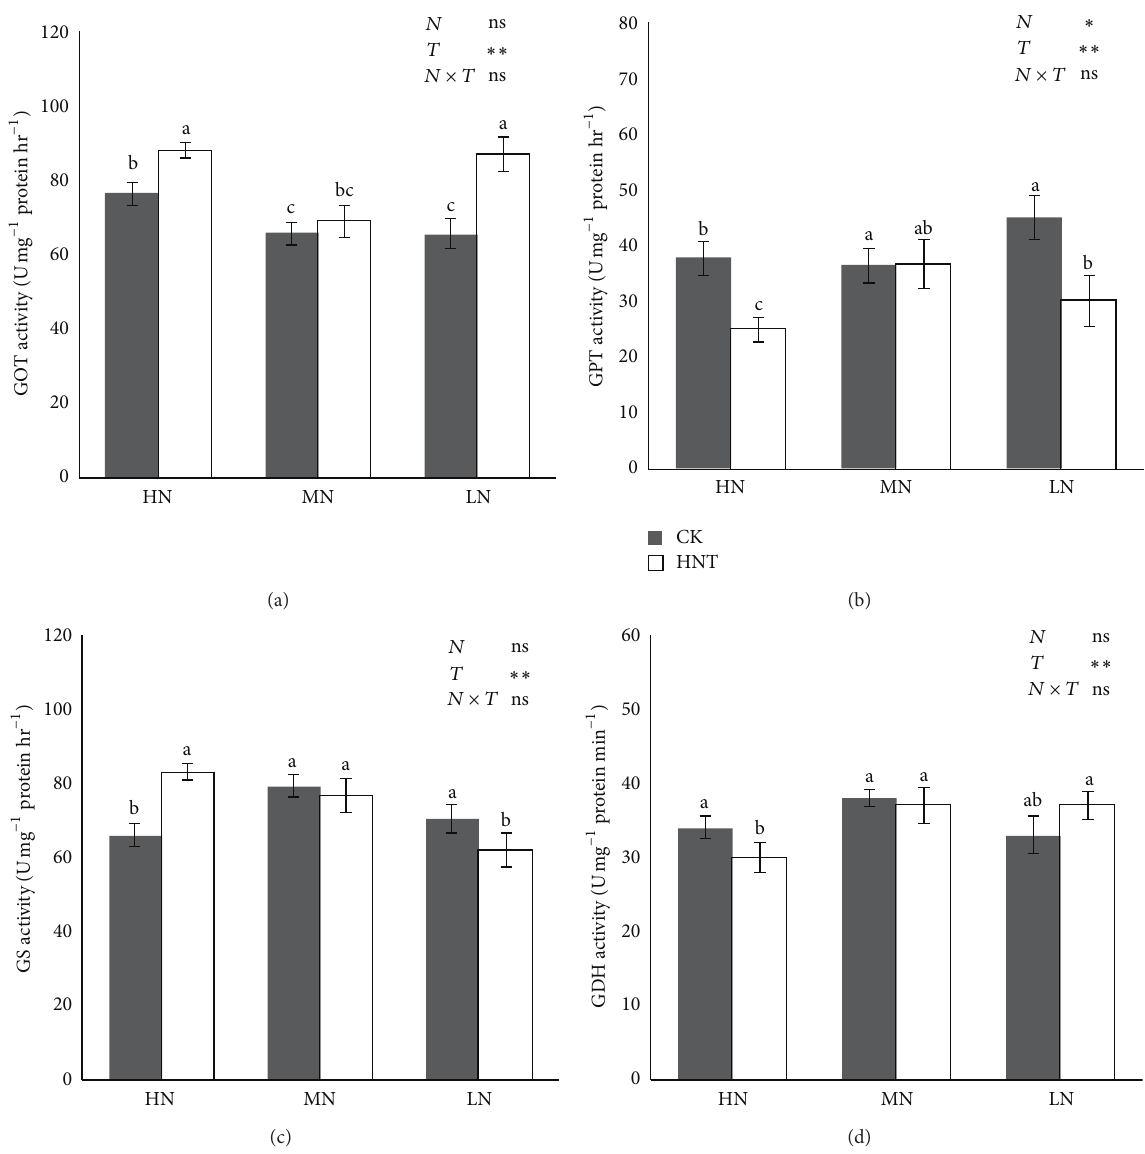
Figure 4: GOT (a), GPT (b), GS (c), and GDH (d) activities of rice seedling leaf. Plants were grown under two different temperatures of 22 ∘ C (CK) and 27 ∘ C (HNT) and three different nitrogen levels of 10mgN/mL (LN), 40mgN/mL (MN), and 160 mgN/mL (HN). Statistical analysis was carried out between temperature treatments using an ANOVA with Tukey’s HSD. Columns with the same letter are not significantly different ( 𝑃 < 0.05